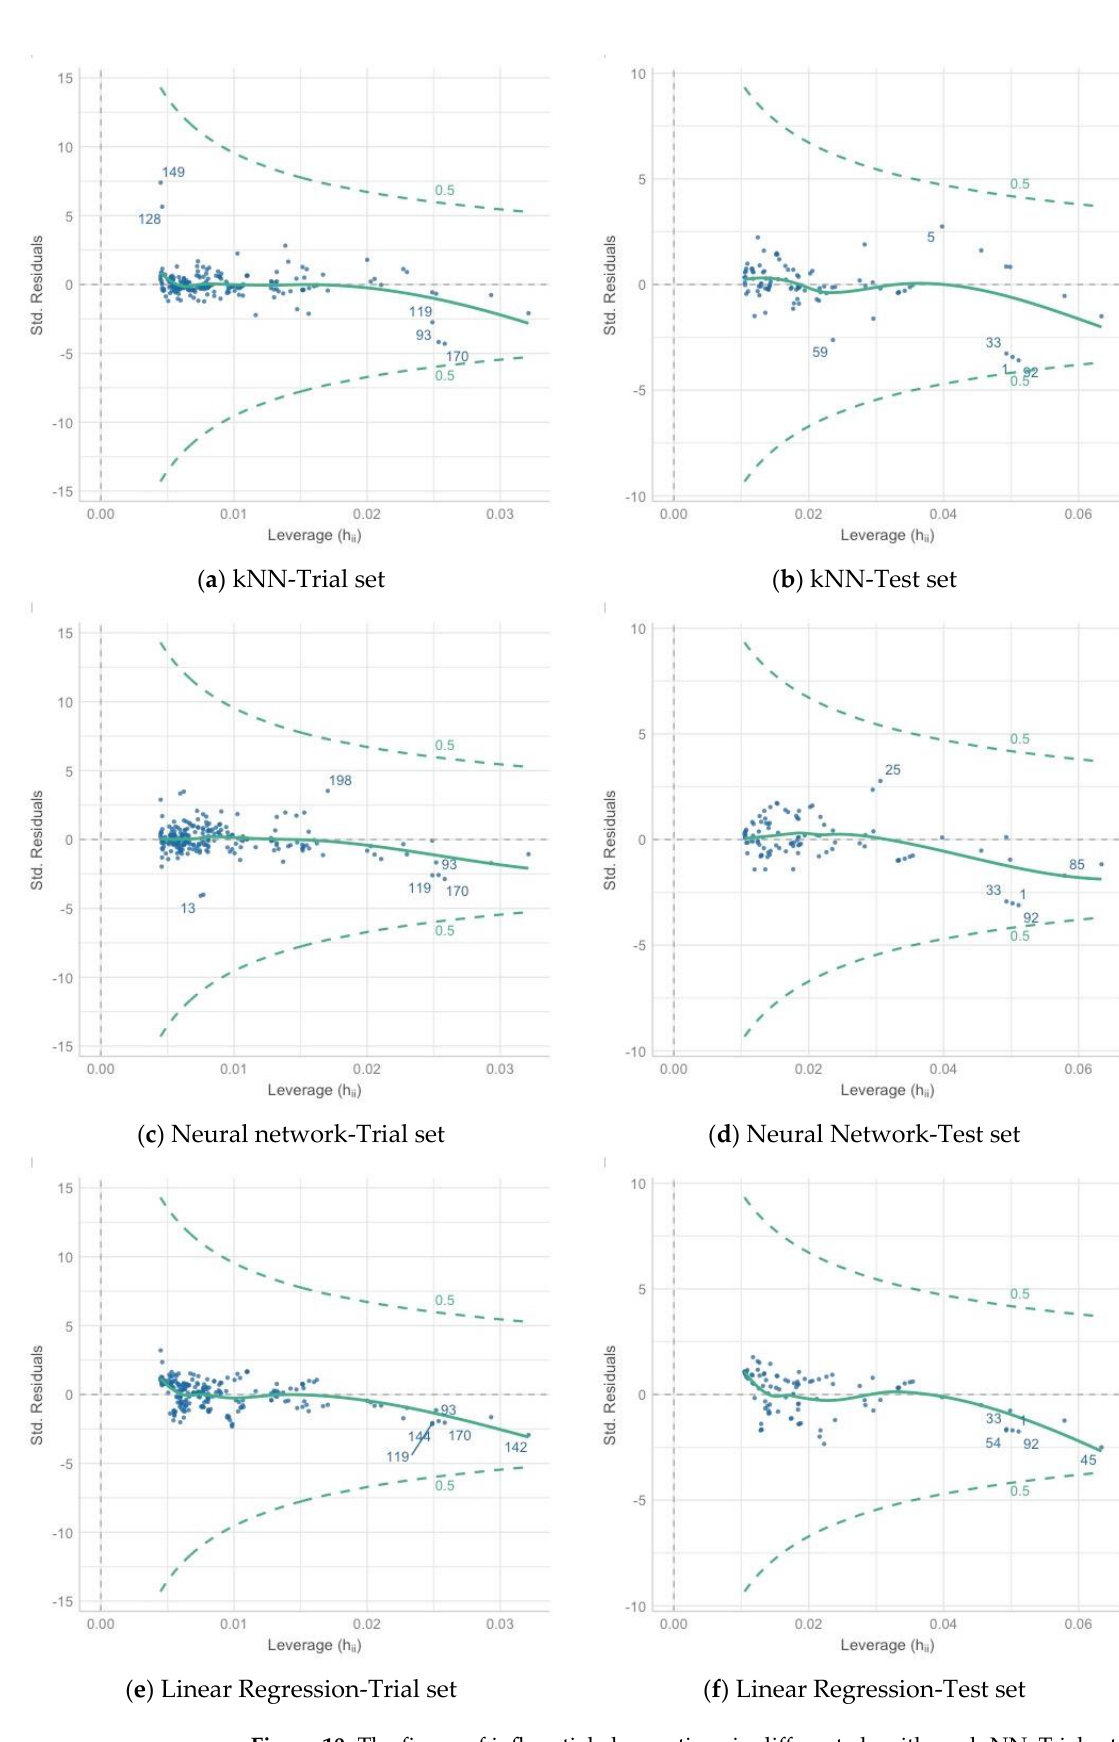
Figure 10. The figure of influential observations in different algorithms: k-NN: Trial set ( a ), Test